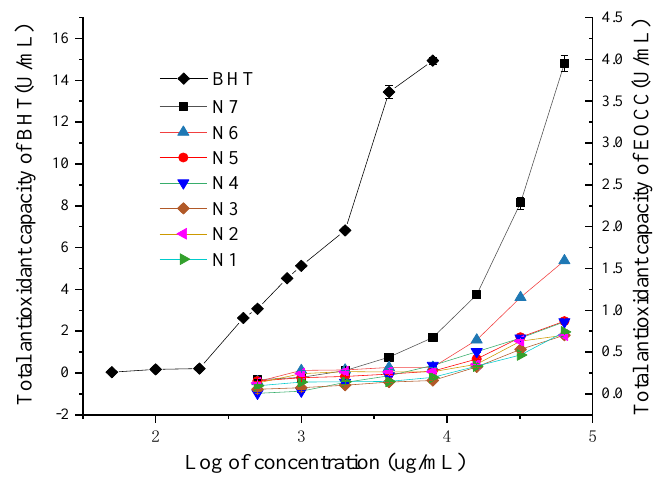
Figure 4. Total antioxidant capacities of the BHT and EOCC.